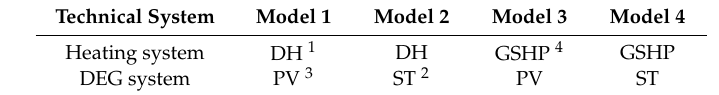
Table 1. The different heating and decentralized energy generation (DEG) combinations